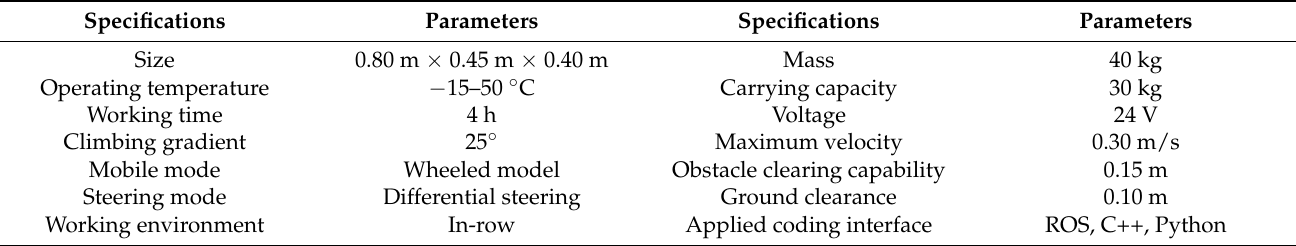
Figure 1. The schematic of HTP robot platform. ( a ) is the system control schematic. ( b ) (1) mast; (2) display screen; (3) power and communication interfaces; (4) sensor trays; (5) IPC; (6) GPS receiver; (7) laser scanner; (8) robot body. Table 1. The specifications and parameters of our HTP